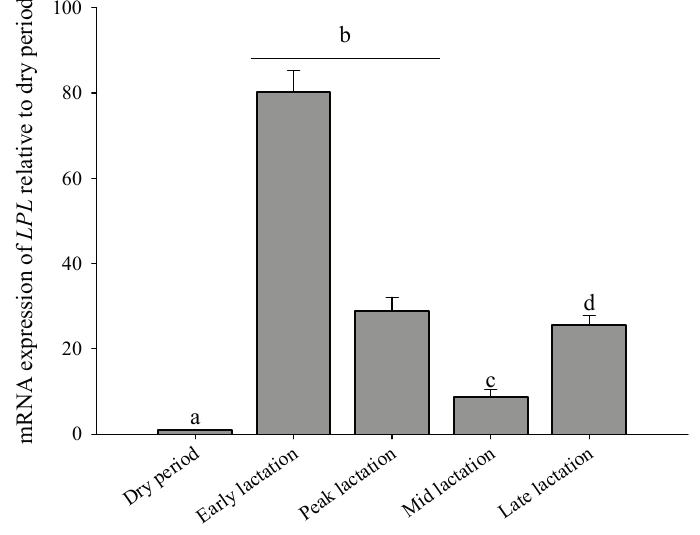
Figure 3. Relative expression analysis of LPL gene in goat mammary gland among five different stages of lactation. The results were expressed relative to the dry period (named 1). Data are calculated using mean ± SD. Dissimilar letters (a, b, c, and d) denote significant differences between different lactations ( p <